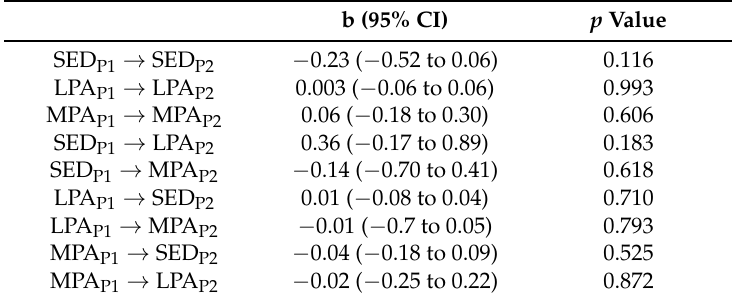
Table 2. Associations between time (min) spent in different physical activity intensities or sedentary time between pairs of consecutive shifts. b (95% CI) p Value SED S1 → SED S2 − 0.43 ( − 1.02 to 0.16) 0.152 LPA S1 → LPA S2 0.01 ( − 0.08 to 0.09) 0.987 MPA S1 → MPA S2 0.14 ( − 0.16 to 0.43) 0.356 SED S1 → LPA S2 − 0.01 ( − 1.11 to 1.09) 0.992 SED S1 → MPA S2 0.47 ( − 0.56 to 1.49) 0.372 LPA S1 → SED S2 − 0.03 ( − 0.08 to 0.02) 0.227 LPA S1 → MPA S2 0.03 ( − 0.05 to 0.11) 0.420 MPA S1 → SED S2 − 0.12 ( − 0.30 to 0.05) 0.175 MPA S1 → LPA S2 − 0.02 ( − 0.34 to 0.30) 0.885